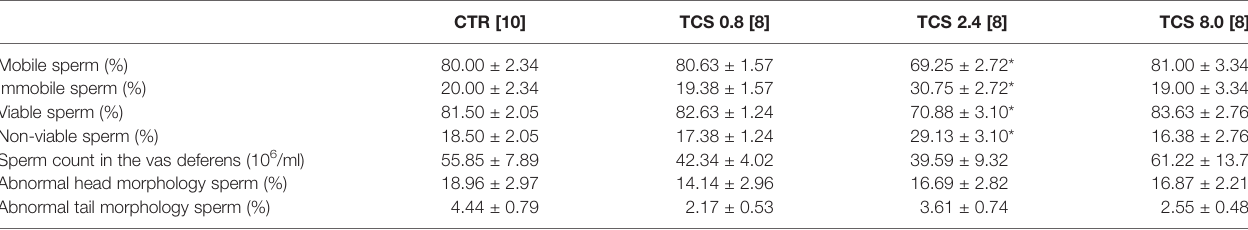
TABLE 3 | Sperm motility, viability, sperm count in the vas deferens, and morphology of male rats of F1 generation at PND 140.